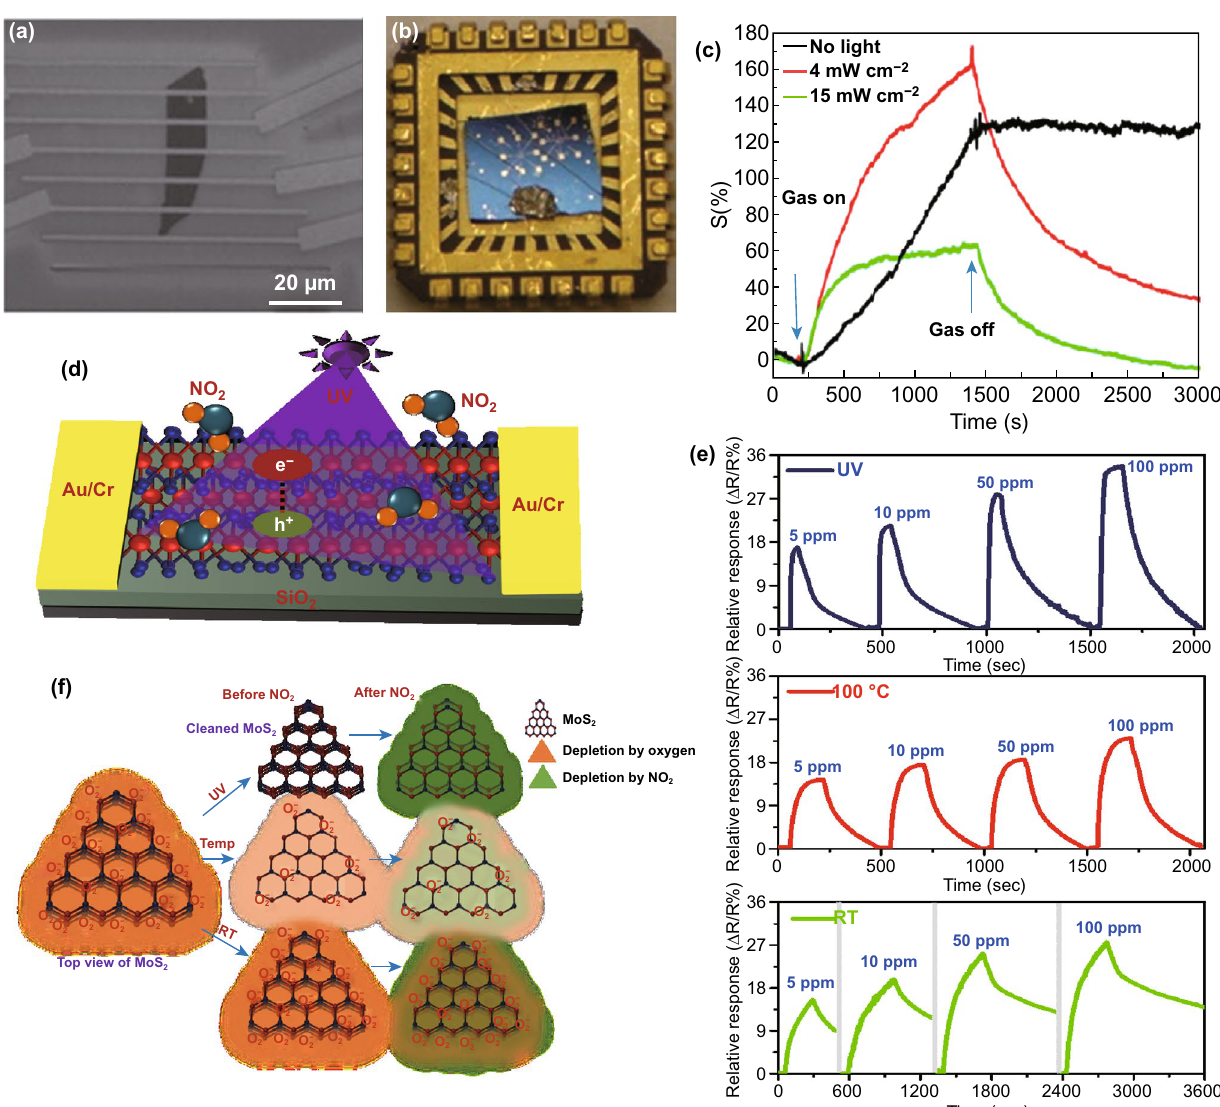
Fig. 13 a SEM image of mechanically exfoliated MoS 2 -based device. b MoS 2 device mounted on the chip. c Sensitivity to NO 2 gas of the MoS 2 sensor under different intensities of the green light source. Reproduced with permission [112]. Copyright 2013, American Chemical Society. d Schematic representation of a CVD grown MoS 2 sensor under UV light illumination. e Transient gas response to different concentrations of NO 2 , and f gas sensing mechanism, of the CVD grown MoS 2 sensor at room temperature, 100 °C and under UV illumination. Reproduced with permission [114]. Copyright 2017, American Chemical